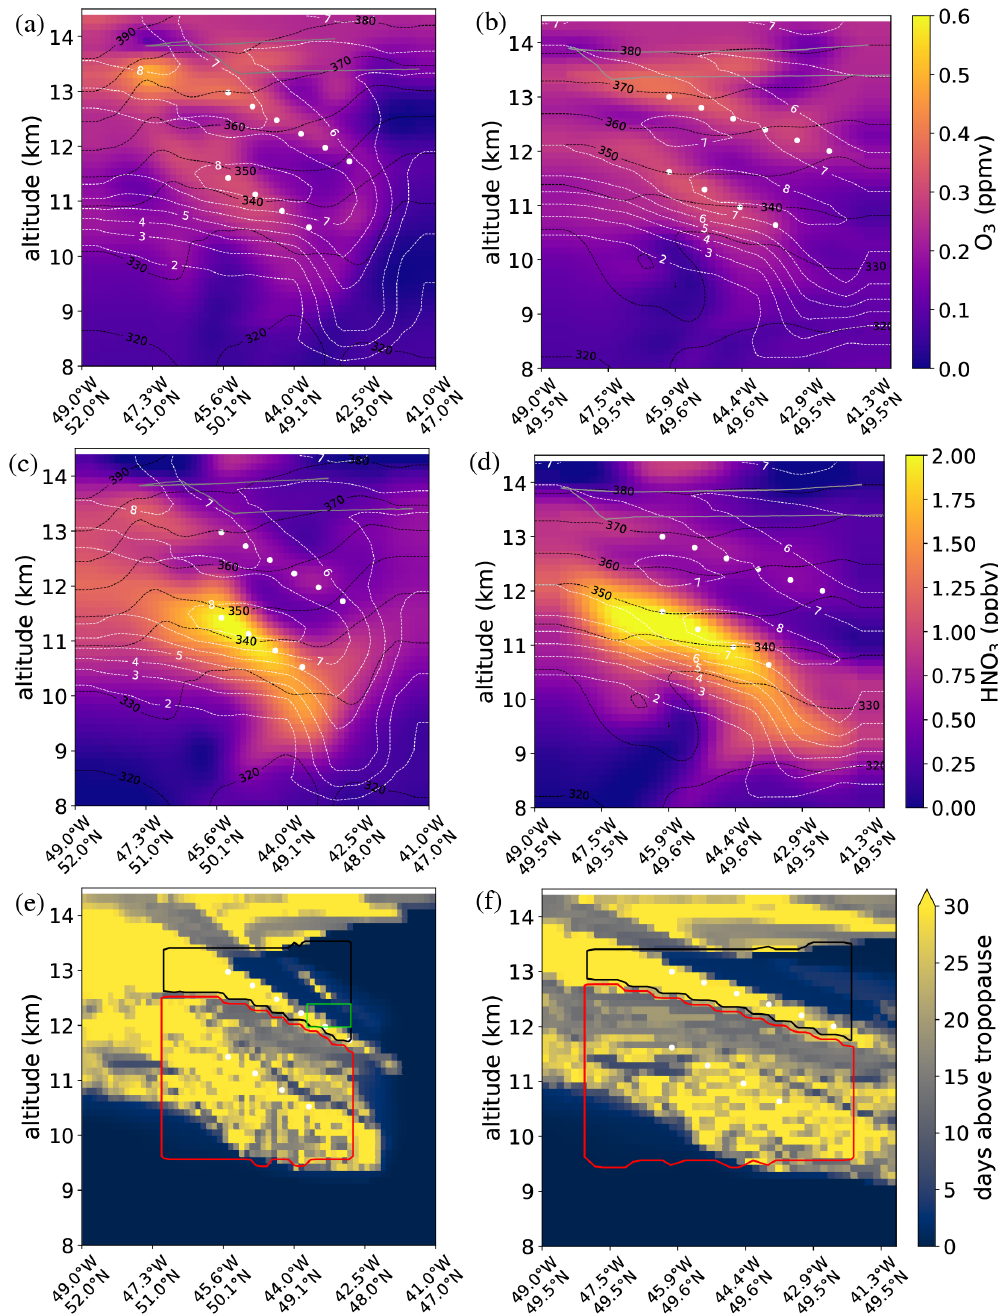
Figure 7. Panels (a–d) show vertical cuts through 3-D tomographic retrieval and corresponding air mass origin plots. The solid grey line shows the projection of flight path onto the displayed cut; dashed black lines indicate isentropes, labelled in K; dashed white lines indicate PV isosurfaces, labelled in PVU. Panels (e–f) show air residence time in the stratosphere; black and red lines show the position of air parcels for which backward trajectories were calculated. Their previous positions are depicted, with those same colours, in Fig. 8. Positions of vertical cuts are shown in Fig. 1a: left panels – magenta; right panels – cyan. White dots mark filaments (see Sect.